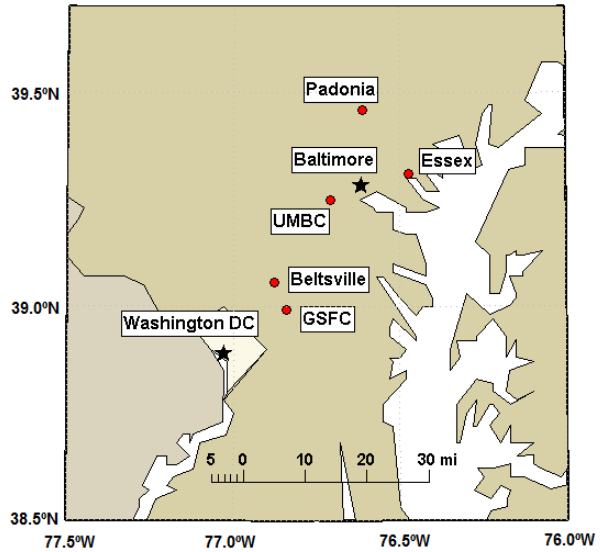
Figure 1. Map of the Baltimore–Washington DC region with the lo- cations considered for the lidar retrievals comparison to AERONET retrievals and in situ airborne measurements during DISCOVER-